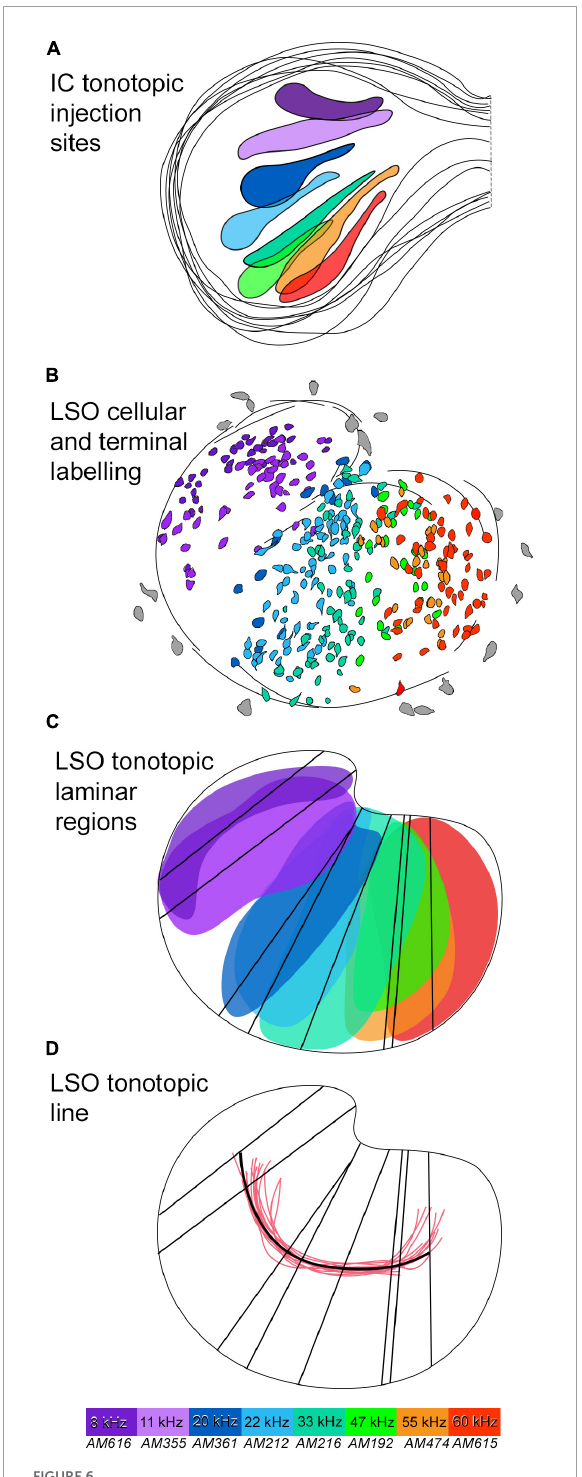
FIGURE6 Tonotopic relationship between the IC and LSO with a tonotopic axis. (A) Several IC injections were made in the dorsal to ventral regions of the CNIC to labeled the correspondingly low to high frequency output in the LSO. 8 IC injection sites were drawn and superimposed to present an IC frequency representation.